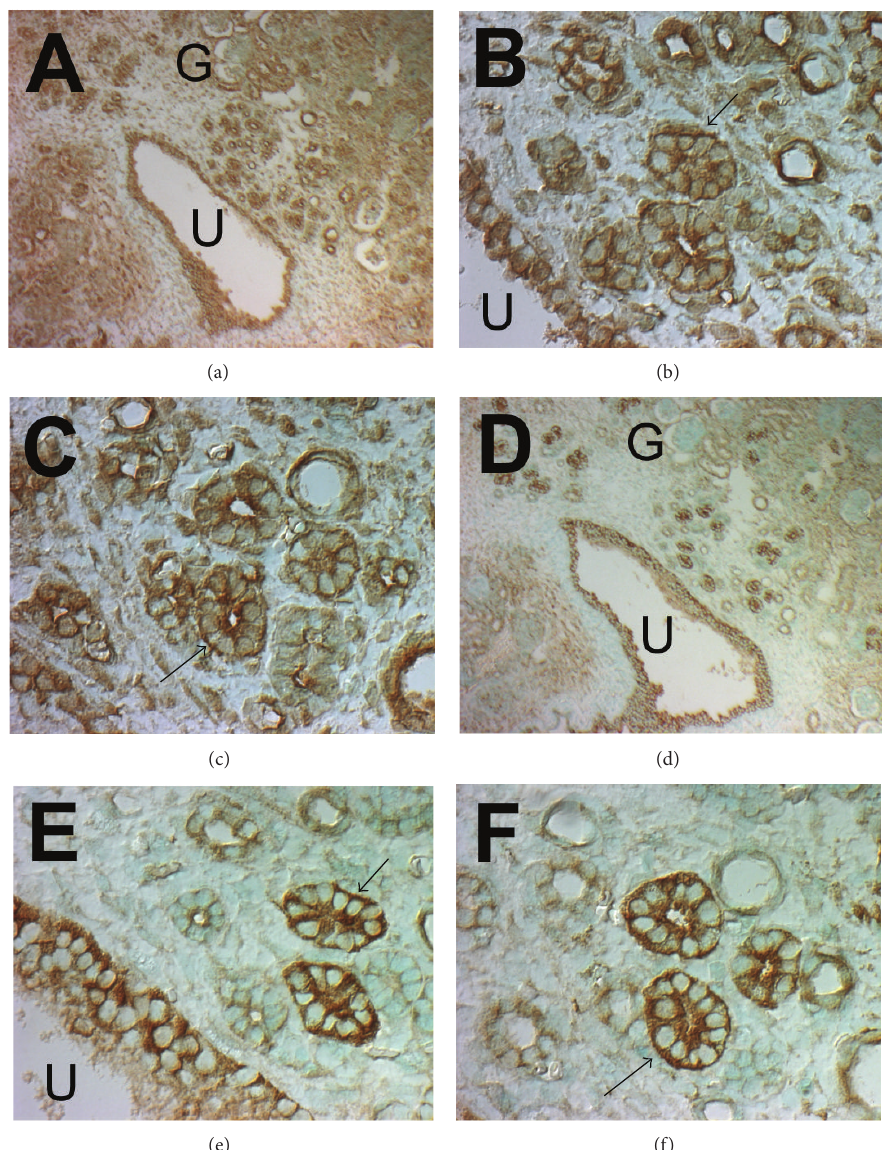
Figure 6: MGP and fibronectin localization in the embryonic rat kidney. (a)–(c) serial section of E20 rat kidney in which fibronectin is localized with mouse-anti-fibronectin and Vectastain ABC elite universal peroxidase-diaminobenzidine and counterstained with methyl green. (d)–(f) Serial section of E20 rat kidney in which MGP localized with rabbit-anti-MGP, Vectastain ABC elite universal peroxidase diaminobenzidine and counterstained with methyl green. A and D are low power images of the same region of kidney taken with the 6.3x objective. U is the lumen of the developing ureter, and G is a developing glomerulus. Fibronectin localized in B and C taken with a 40x oil immersion objective. U is the lumen of the developing ureter. Arrows indicate tubules identical to those shown in the serial section. MGP localized in E and F, image of equivalent fields as B and C, taken at the same magnification with a 40x objective. U is the developing ureter. Arrows indicate intensely stained tubules for